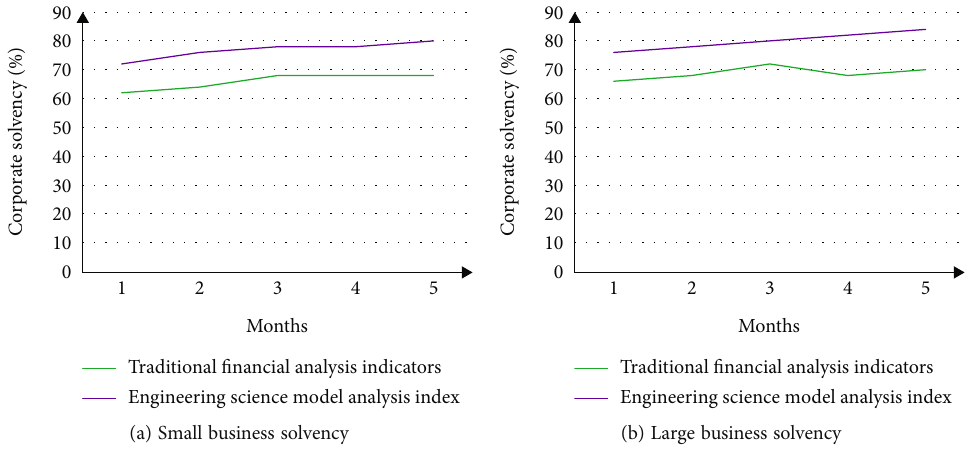
Figure 5: Comparison results of corporate solvency.